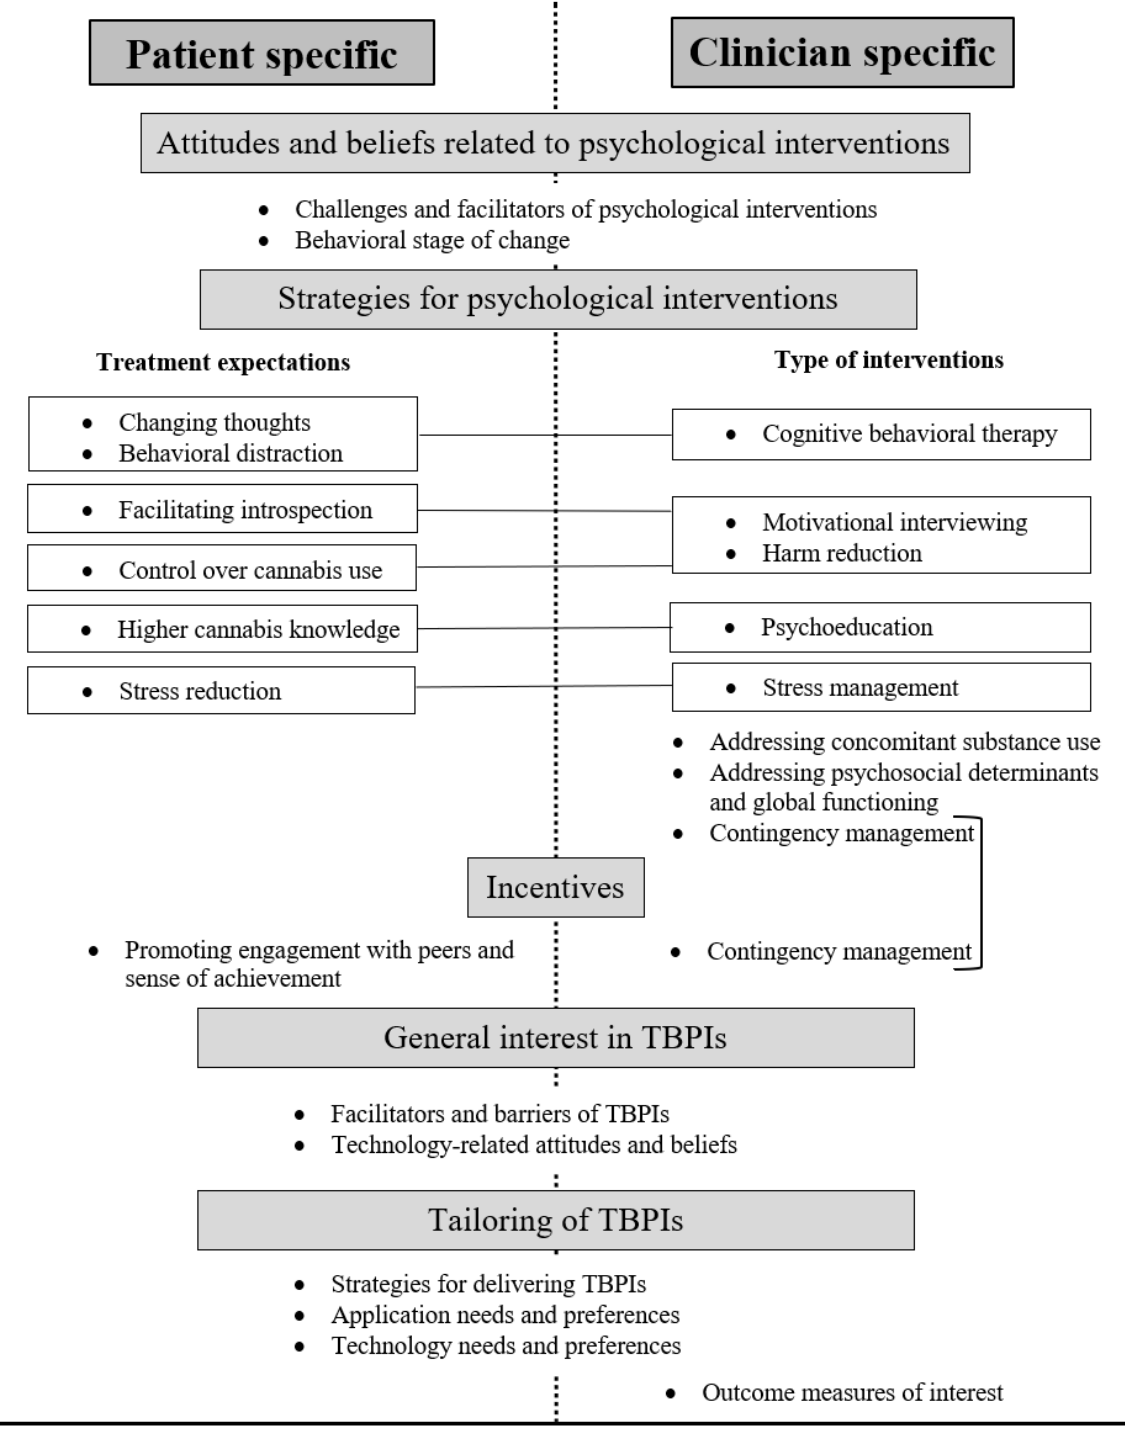
Figure 1. Integration of patient and clinician perspectives related to technology-based psychological interventions. TBPIs: technology-based psychological